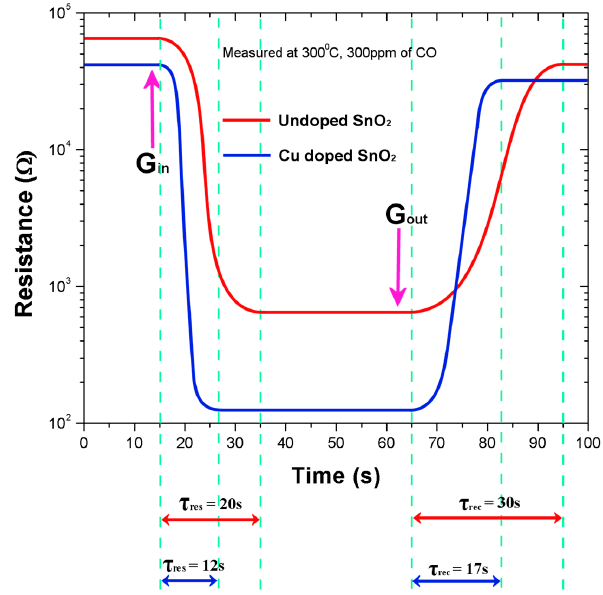
Figure 8. The response ( τ res ) and recovery ( τ rec ) times of the pure and Cu-incorporated SnO 2 pellets. Table 2. Sensitivity, response, and recovery times of pure SnO 2 and Cu:SnO 2